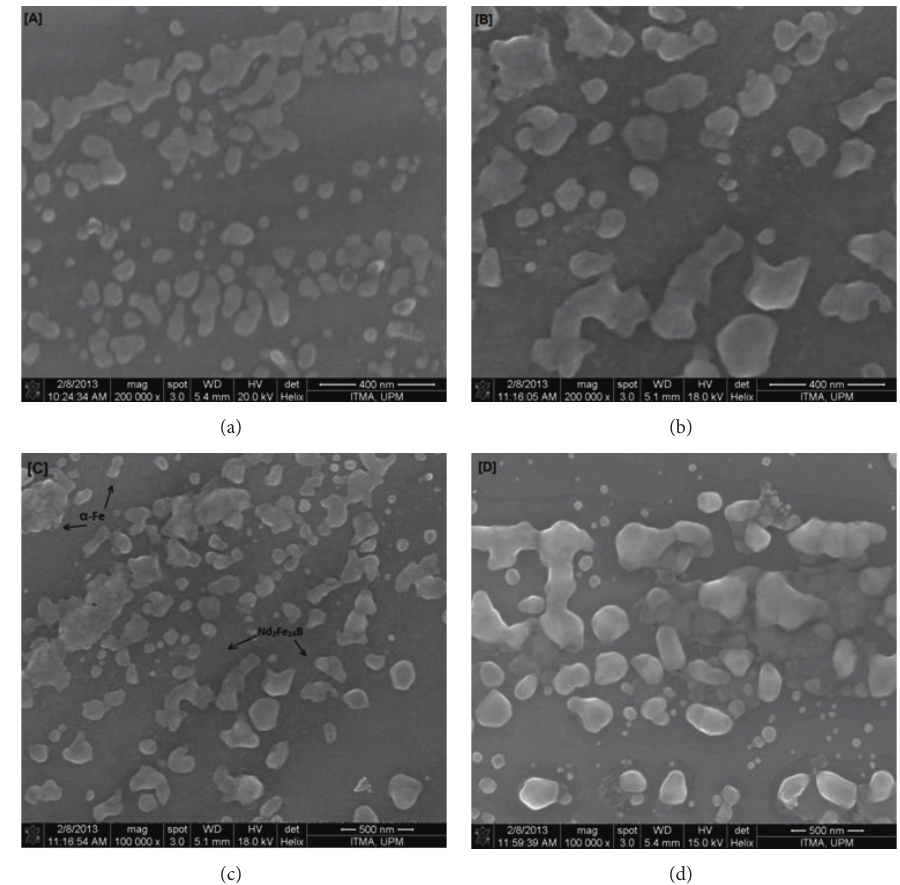
Figure 4: FESEM morphologies of Nd 9.4 Pr 0.6 Fe 74.5 Co 6 B 6 Ga 0.5 Ti 1.5 C 1.5 at (a) 600 ∘ C, (b) 650 ∘ C, (c) 700 ∘ C, and (d) 750 ∘ C annealed ribbons for 10 minutes.